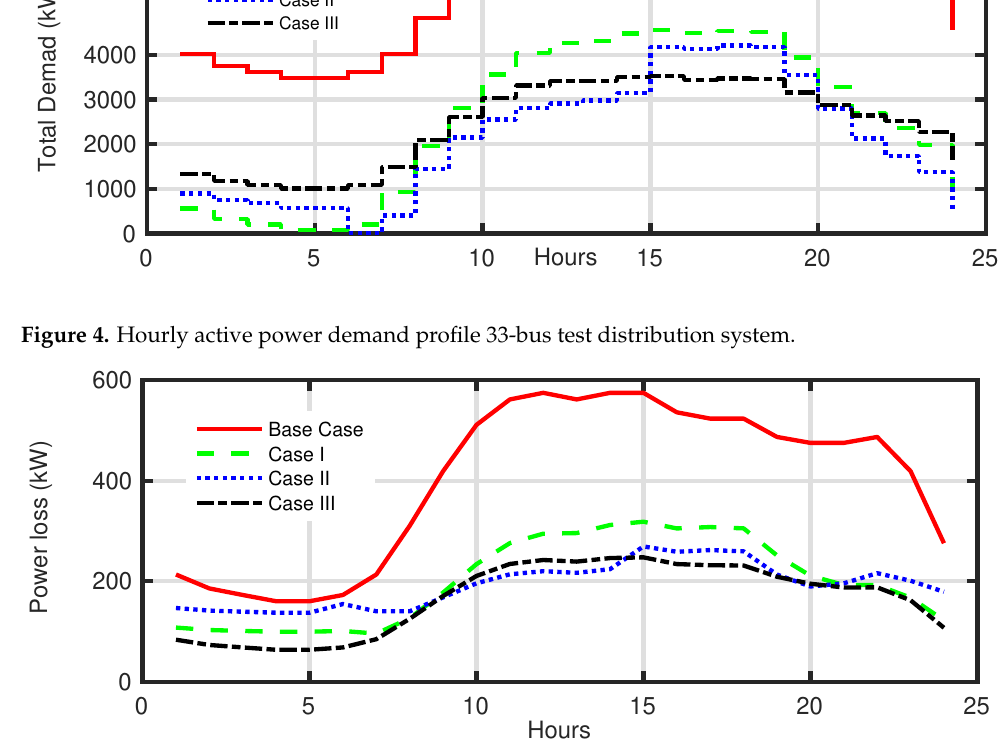
Figure 5. Hourly active power losses 33-bus test distribution